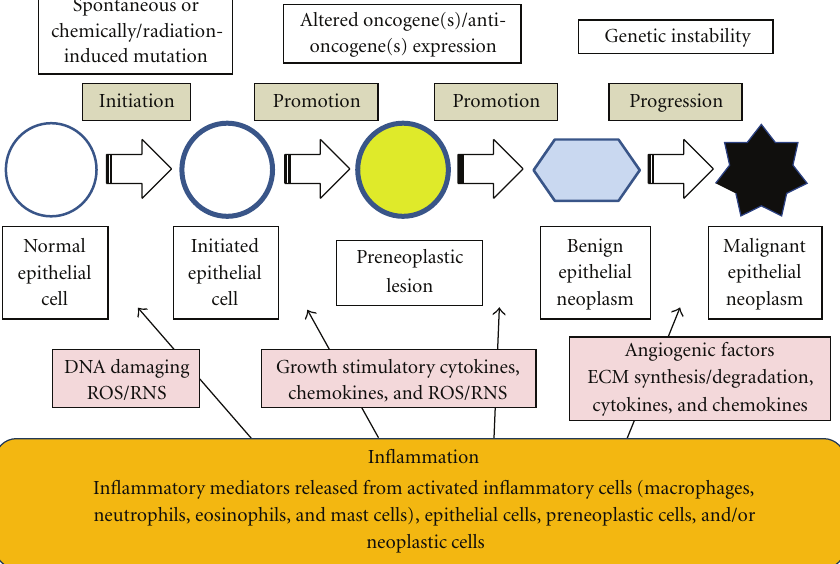
Figure 11: Working hypothesis of the involvement of inflammation in multistage